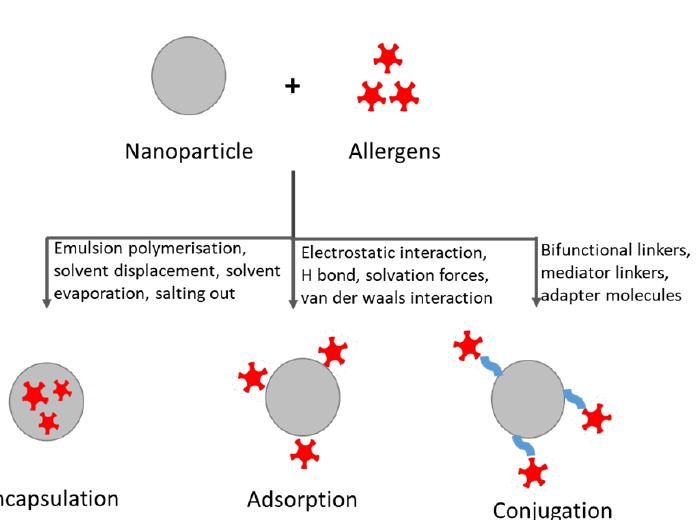
Figure 3. Methods of loading allergens into or onto nanoparticles.